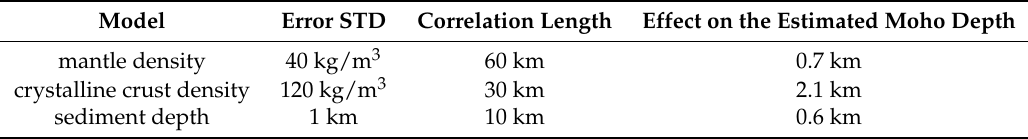
Table 2. Effect of the considered input uncertainties on the final Moho